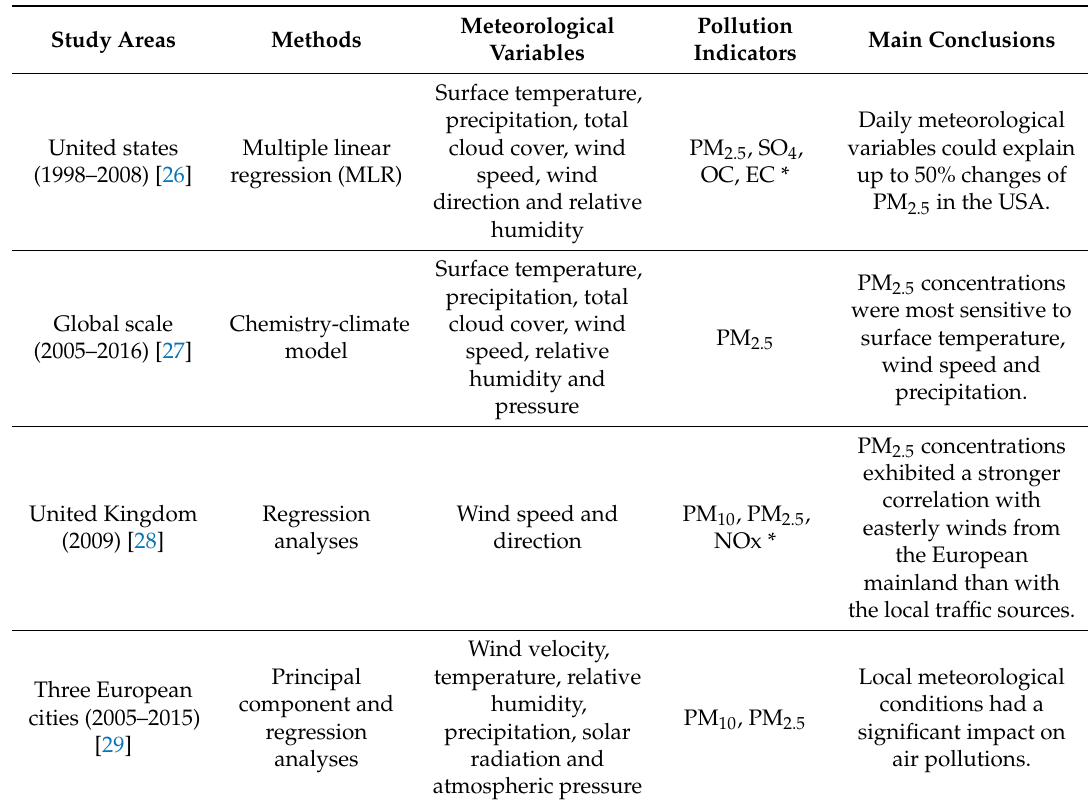
Table 1. Empirical Studies of the impacts of meteorological conditions on PM 2.5 (i.e., particle matter with diameter of 2.5 µ m or less)